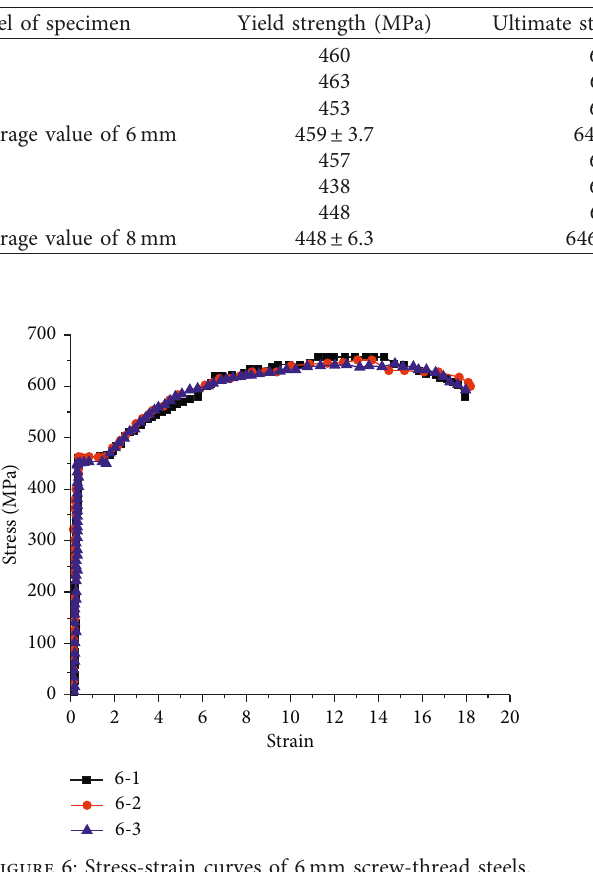
7: Stress-strain curves of 8mm screw-thread steels.